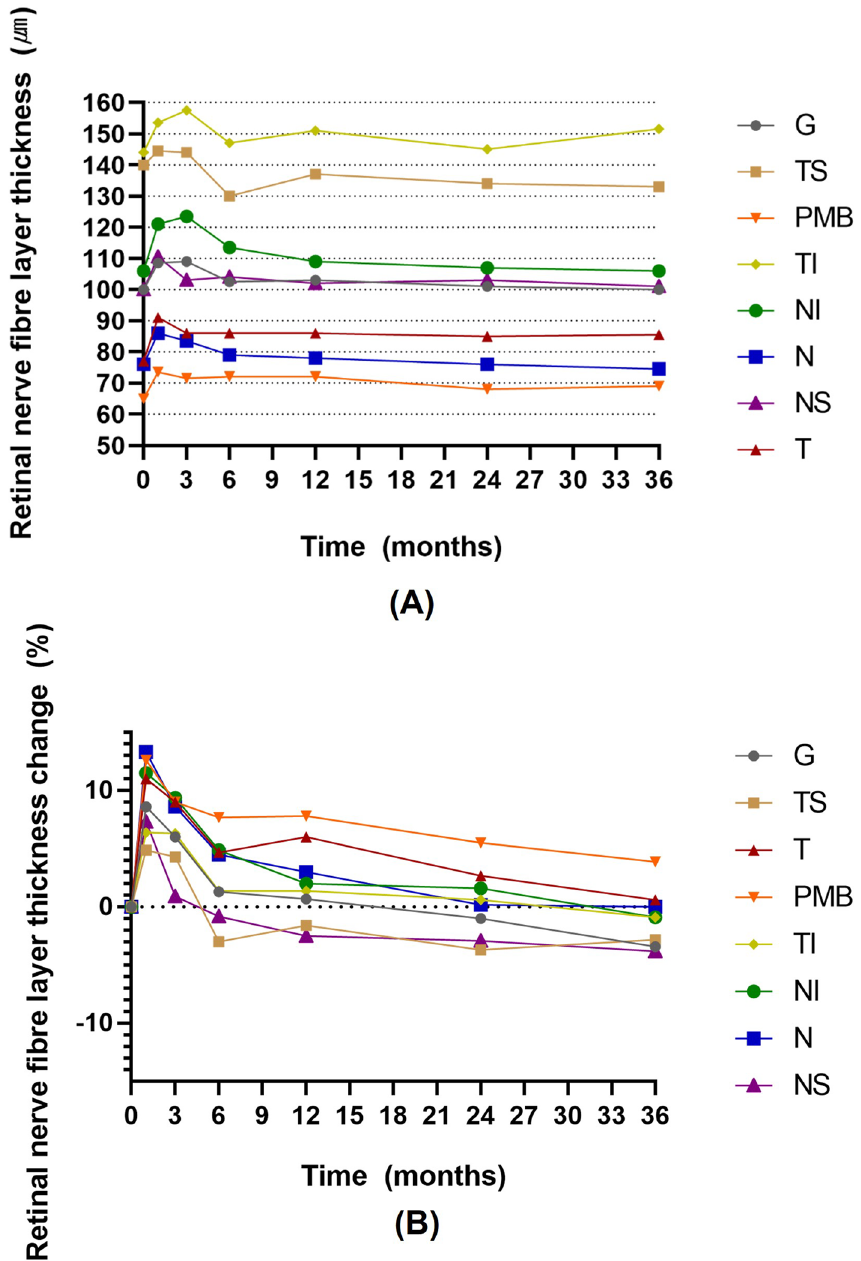
Figure 1. ( A ) Changes in retinal nerve fiber layer (RNFL) thickness of global area (G), temporal superior (TS), temporal inferior (TI), nasal superior (NS), nasal inferior (NI), temporal (T), nasal (N) sectors, and the papillomacular bundle (PMB) in eyes with rhegmatogenous retinal detachment after vitrectomy. ( B ) Relative changes presented as (RNFL thickness at follow-up visit—RNFL thickness at baseline visit/RNFL thickness at baseline visit) × 100 in G, TS, TI, NS, N, T, N sectors, and PMB in eyes with rhegmatogenous retinal detachment after